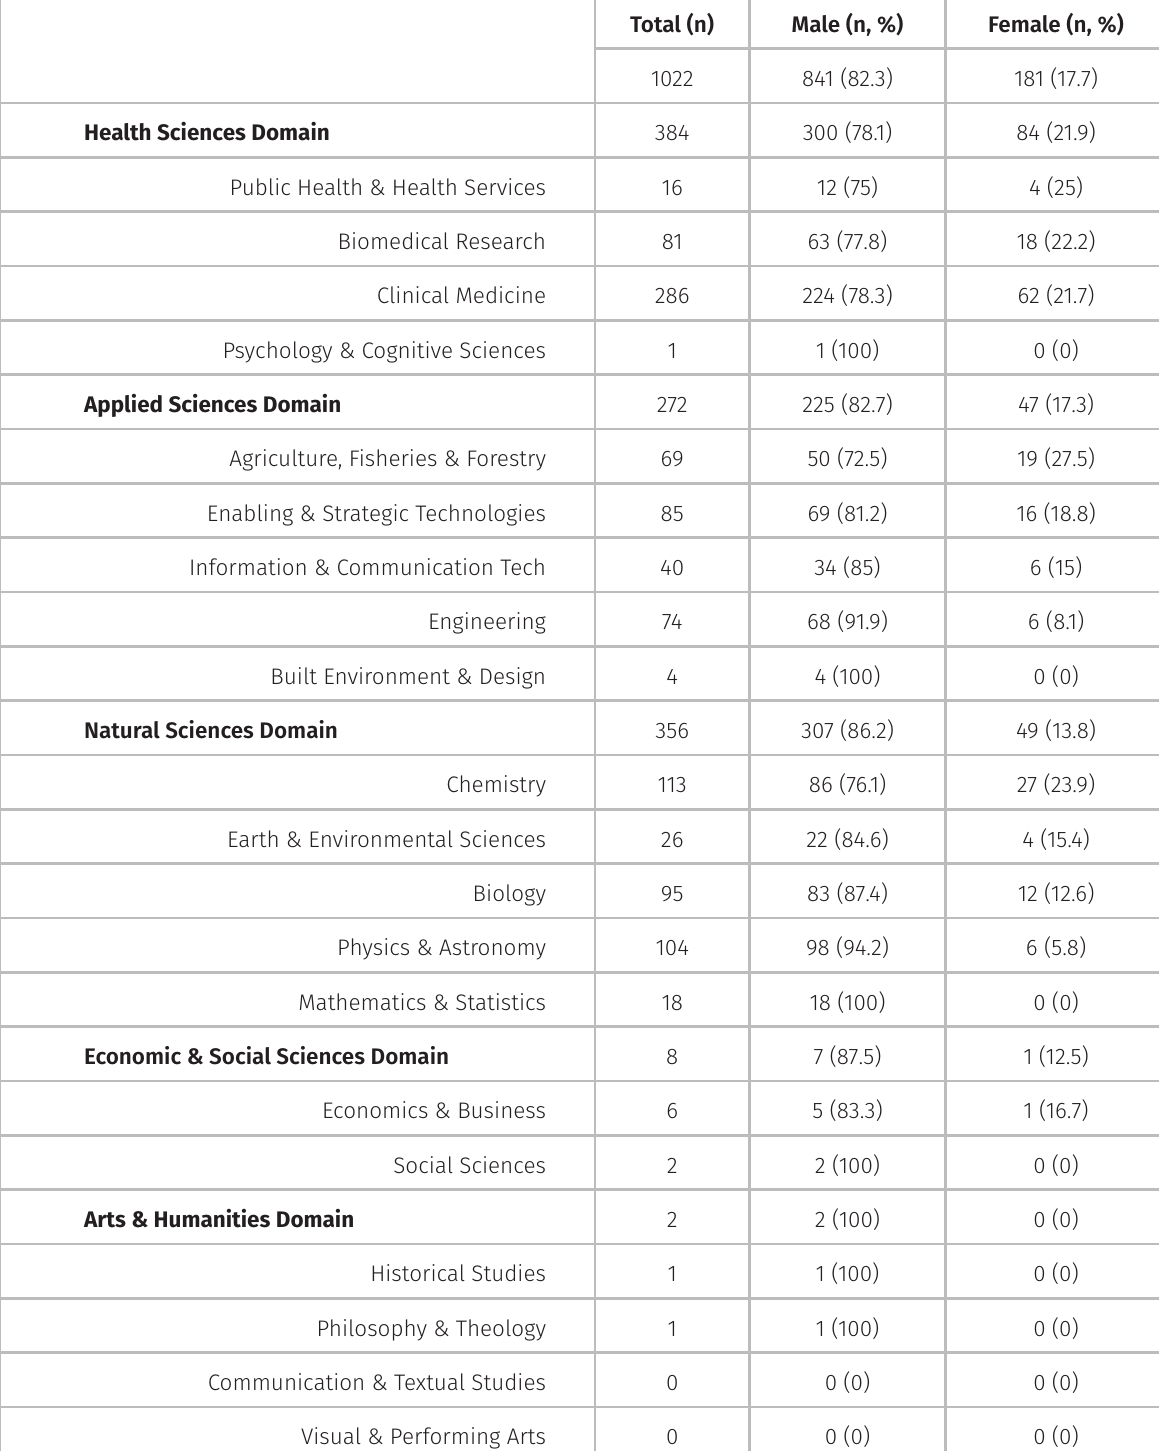
Table I. Brazilian scientists participation in the rank by domain and